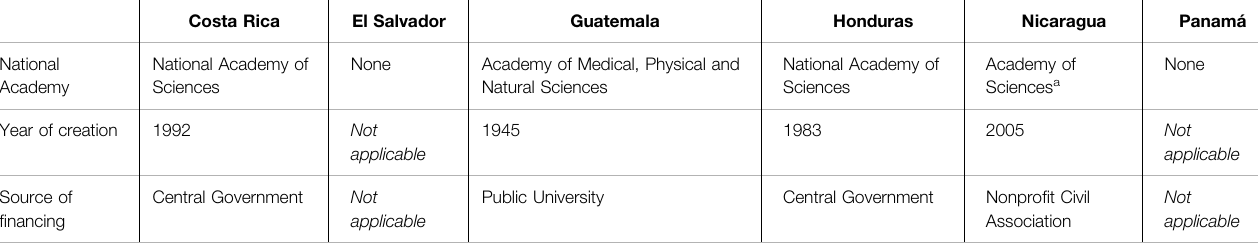
TABLE 1 | Year of creation and sources of fi nancing of National Academies in Central